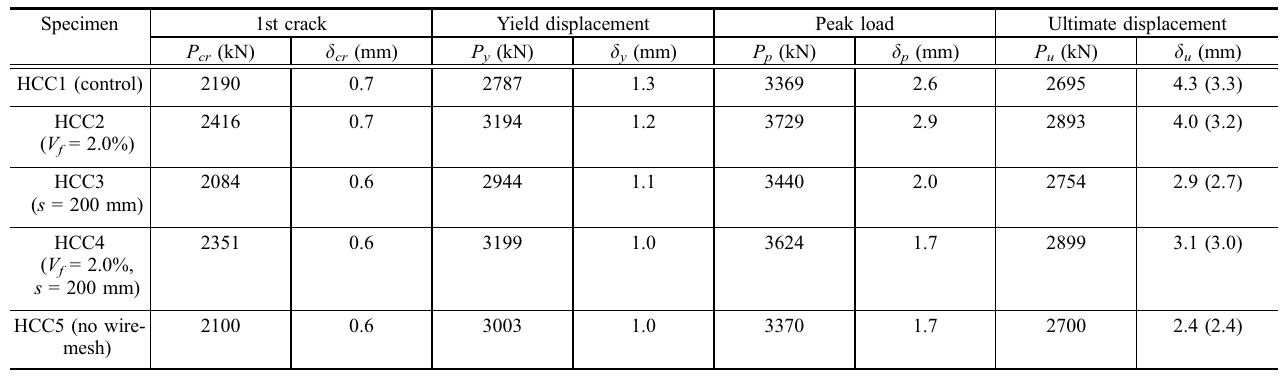
Fig. 9 Strains of transverse Table 5 Test results.